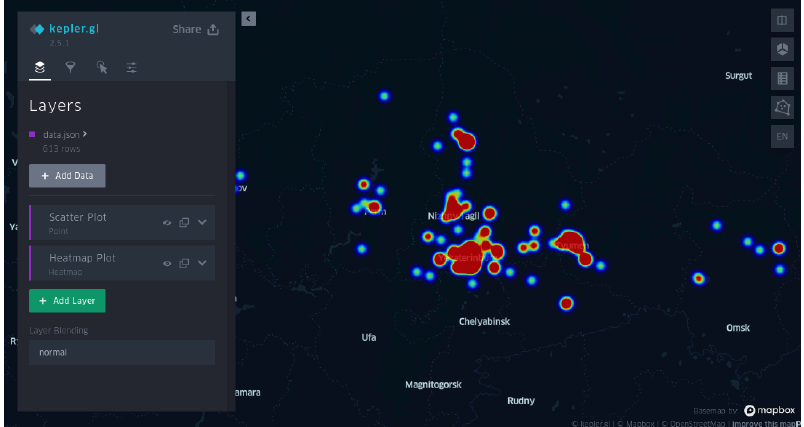
Figure 4. Visualization of viral distribution on the geographical map. The visualization is generated by the web application “Kepler.gl” [29]. The figure shows a heatmap of strains for clusteron 3A across the Ural